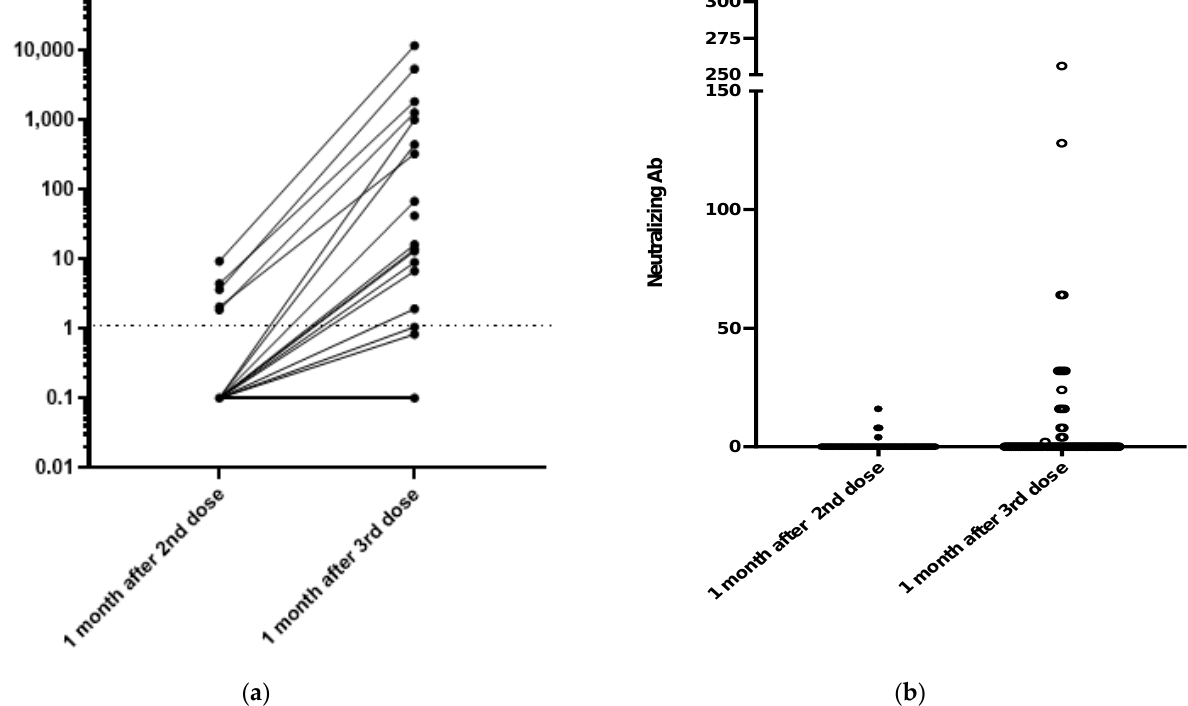
Figure 1. Humoral responses 1 month after the second and the third dose of the mRNA-1273 vac- cine. ( a ) Anti-S results using the Wantai assay and ( b ) neutralizing antibodies results. Only 11 (17.5%) of the 63 patients who were seronegative before their third dose became seropositive (median titer 13 (1.7 – 658) BAU/mL) 4 weeks after their third dose. Their median neutralizing antibody titer was 16 (2 – 64).